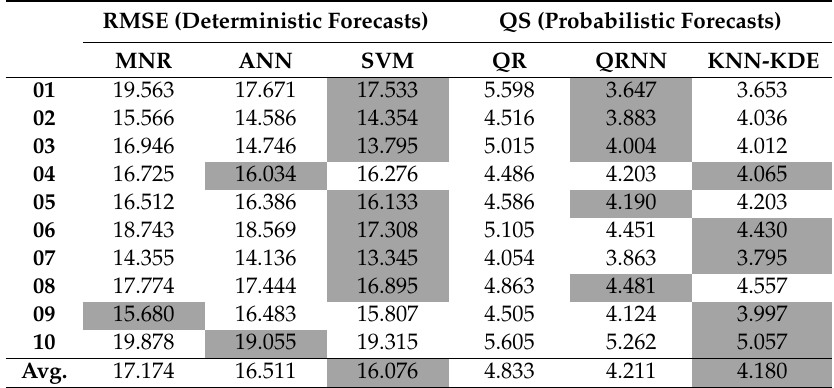
Table 1. Forecast errors of ten wind farms under no false data attack. RMSE (Deterministic